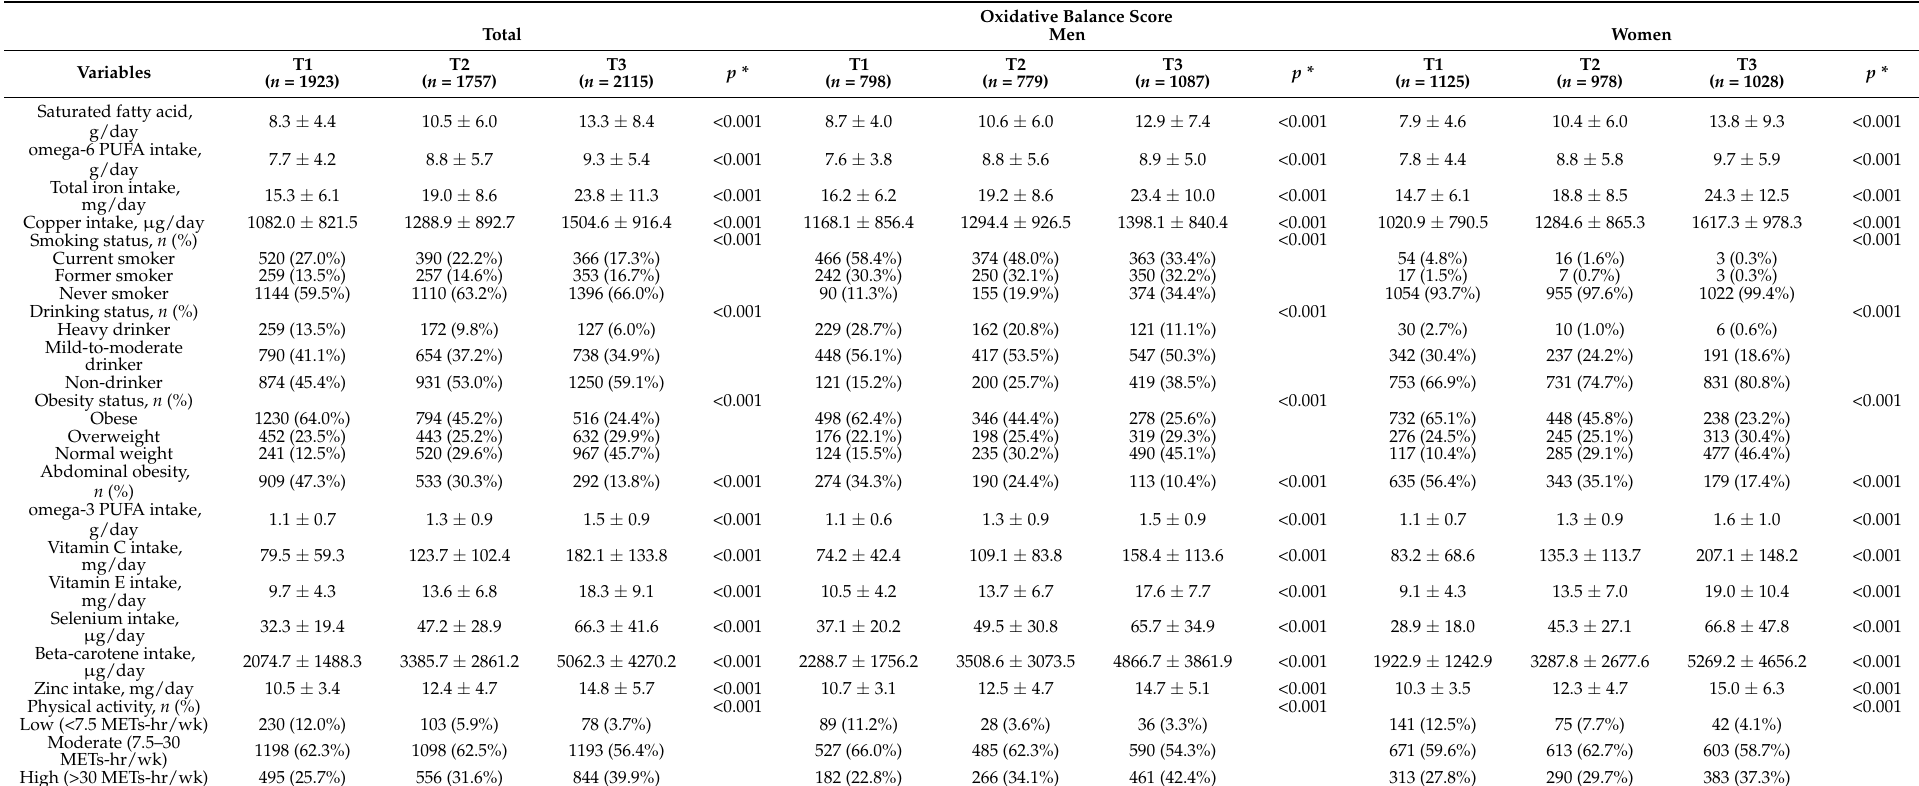
Table 3. Individual components of the score according to oxidative balance score